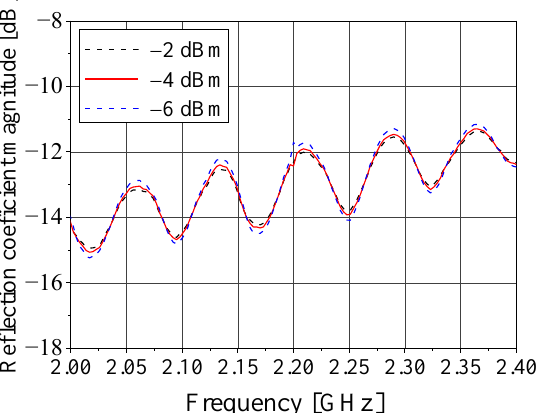
Figure 13. Reflection coefficient at the RF input port (RF in ) of the comparison circuit.